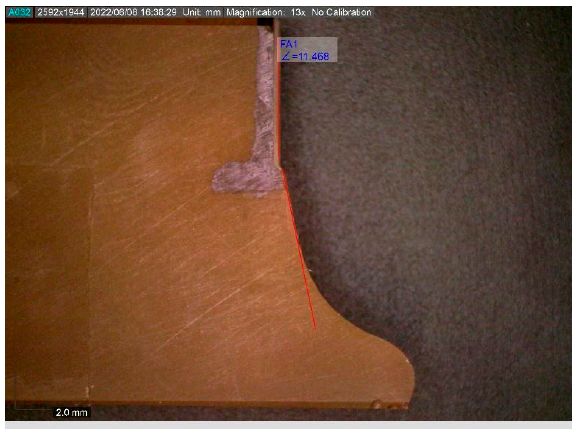
Figure 5. Estimation of angular direction of crack growth using a digital microscope.